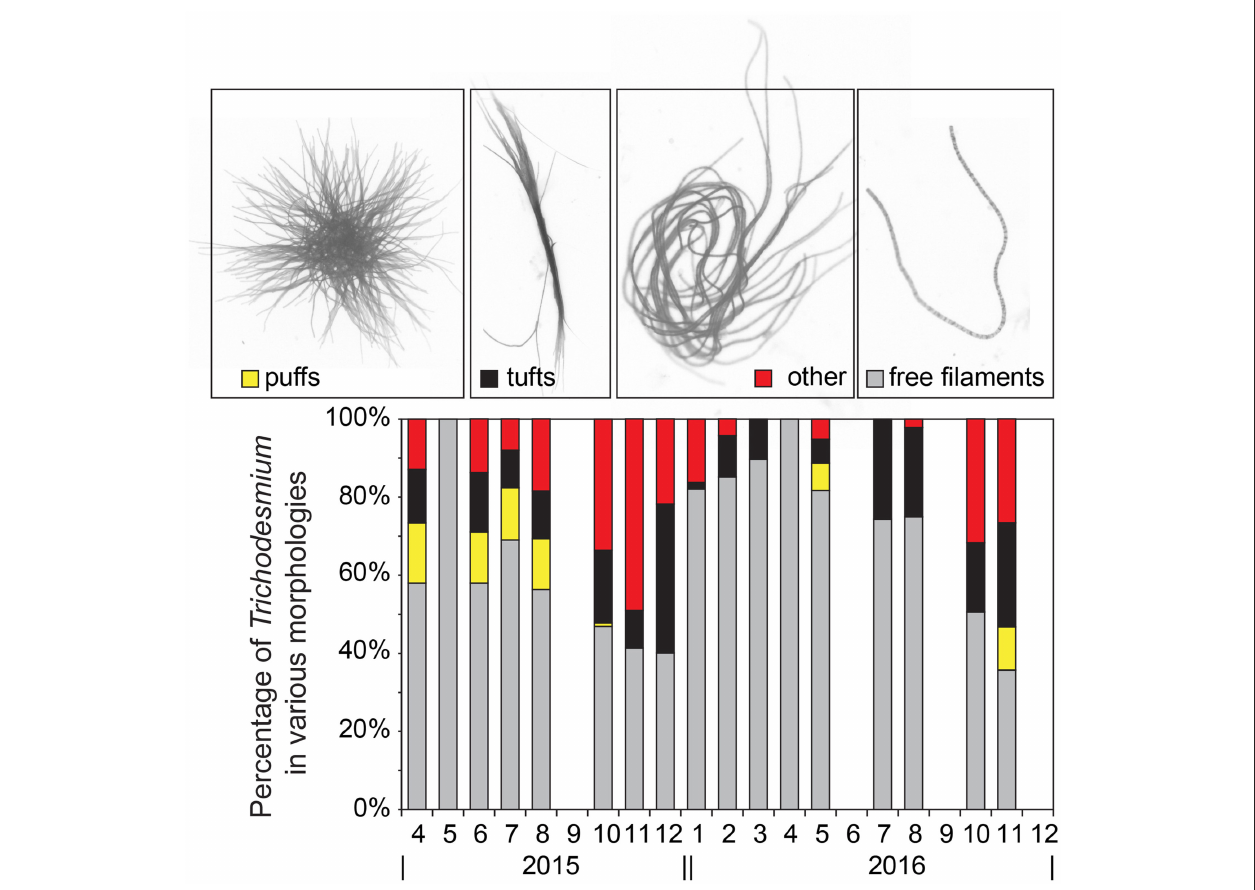
FIGURE 1 | Percentage of Trichodesmium cells in the various morphologies shown in the micrographs on top from left to right: puffs (yellow stacked bar), tufts (black stacked bar), other colonial morphologies (red stacked bar), and free filaments (gray stacked bar).